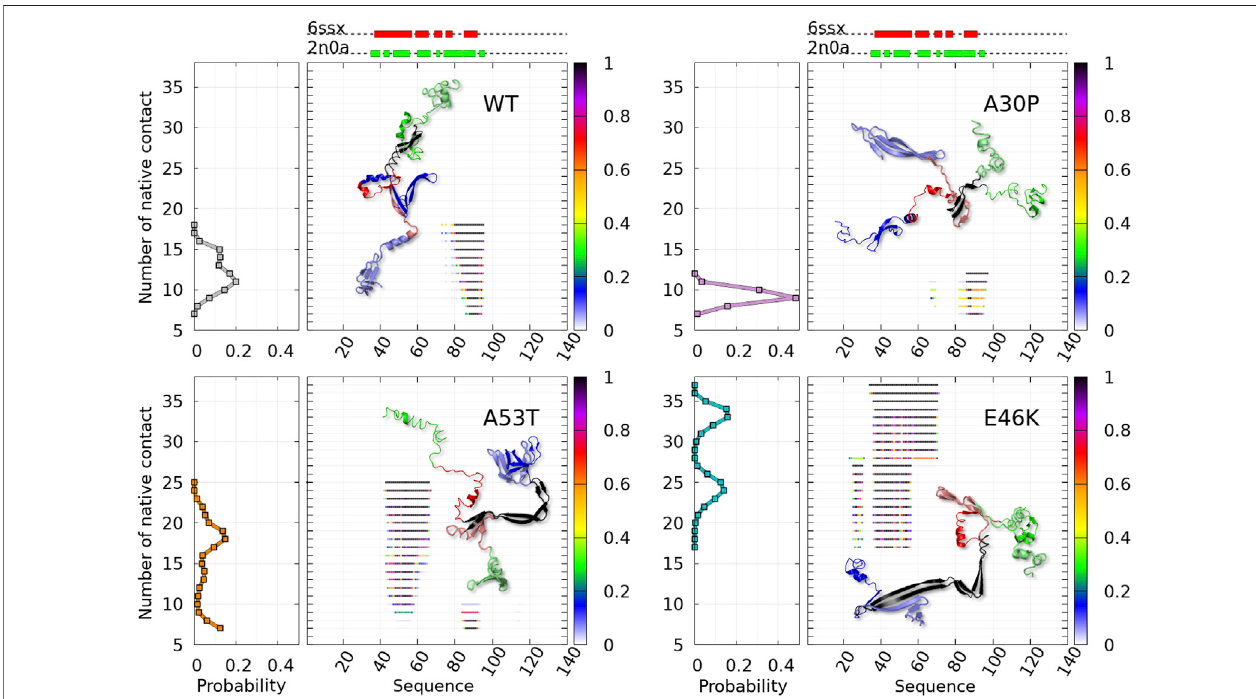
FIGURE 9 | Analysis of the mean contact probability along the amino-acid sequence for the sub-ensemble of Dfncs found in MD trajectories for the WT and variants. Foreachprotein, theleftpanelrepresentstheprobabilitydensityofthenumberofcontactsandtherightpanelrepresentsitsdistributionalongthesequencefor eachpointofthedistribution,withacolorcodegivingtheprobabilityateachresidueaccordingtothecolorbarontheright.3Dstructurerepresentativesofthemaximum number of native fi bril-type contacts are shown with the following color: N-terminal (blue), NAC (red), C-terminal (green), and native contact region (black).